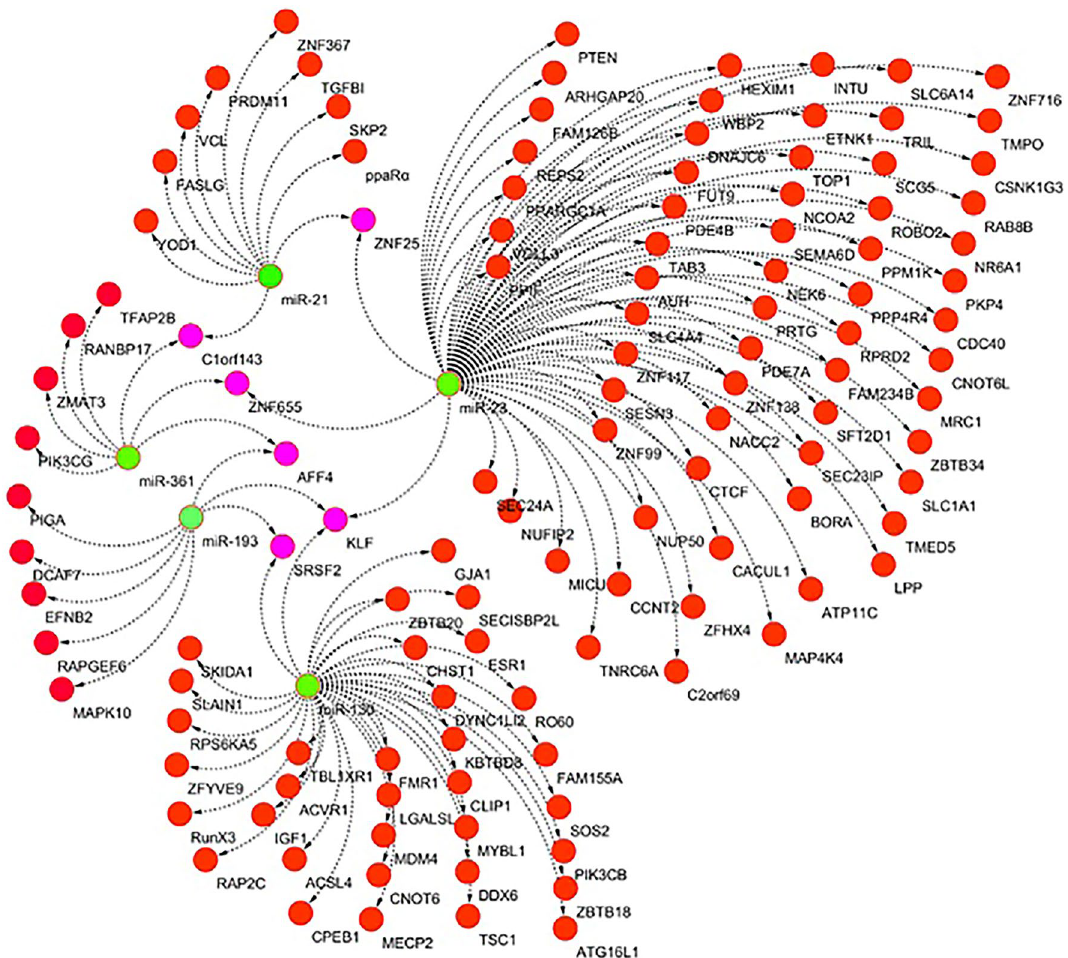
Figure 4. In-silico analysis of dysregulated microRNAs in the first trimester. Green and purple colors indicate dysregulated microRNAs and their common target genes, respectively. ZNF25, RANBP17, CLORF43, ZNF655, AFF4, KLF and SRSF2 were targeted in a common node of microRNAs. Interaction pathway provided by Cytoscape tool version